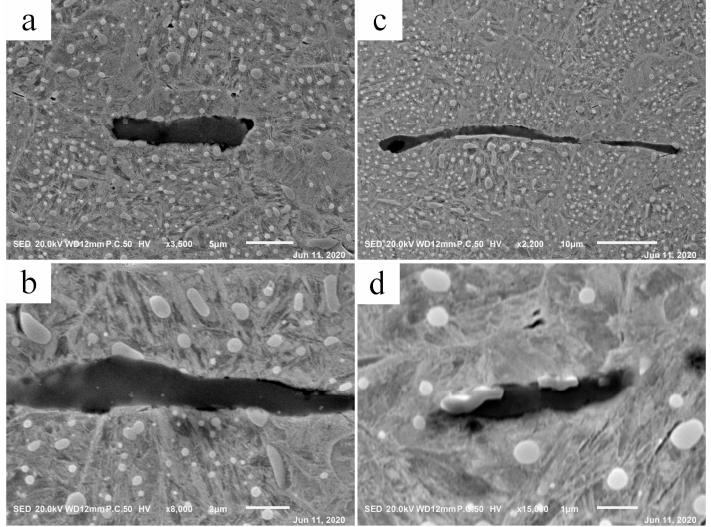
Figure 14. Local separation of inclusions from matrix in raw materials. ( a – d ) Specific examples observed by